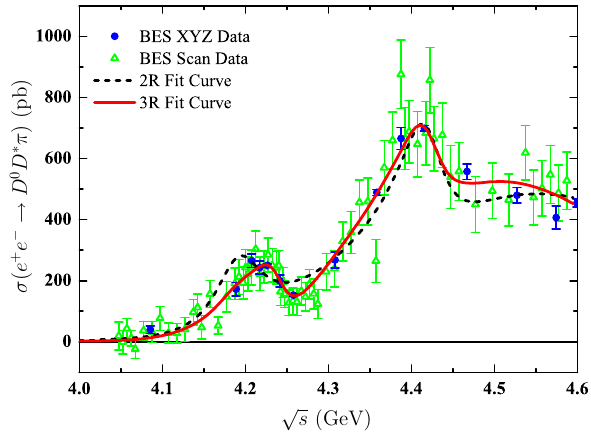
Fig. 4 The same to Fig. 3 but for e + e − → D 0 π + D ∗− process (color